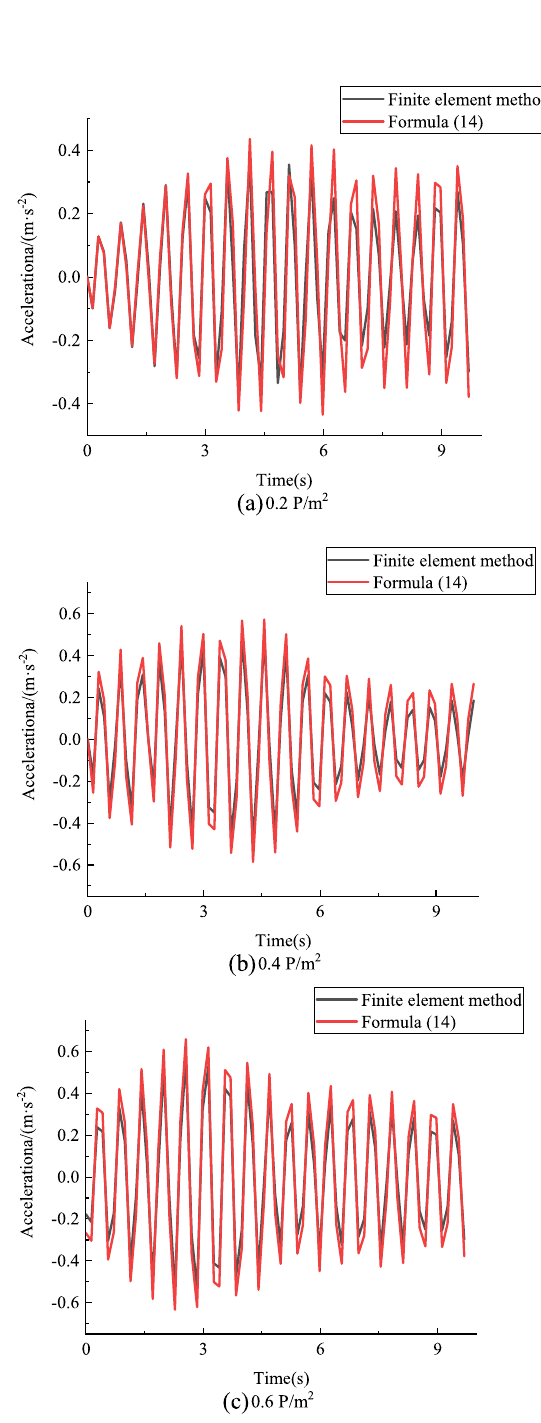
Fig. 7 Comparison of two acceleration time history curve under different crowd